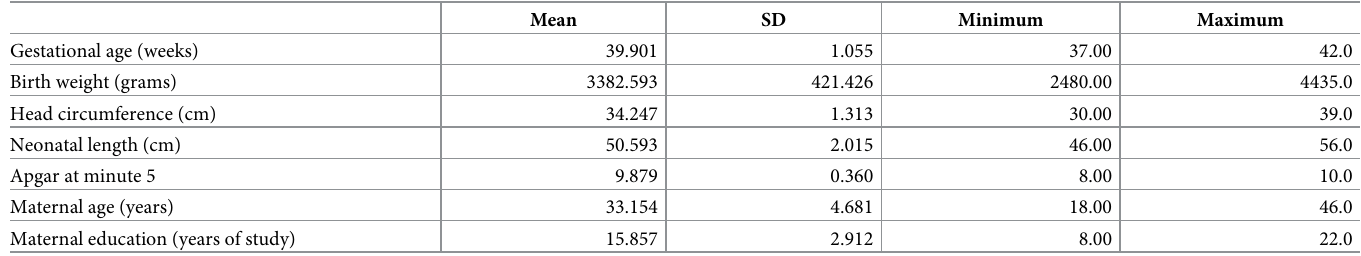
Table 3. Sample description (N =